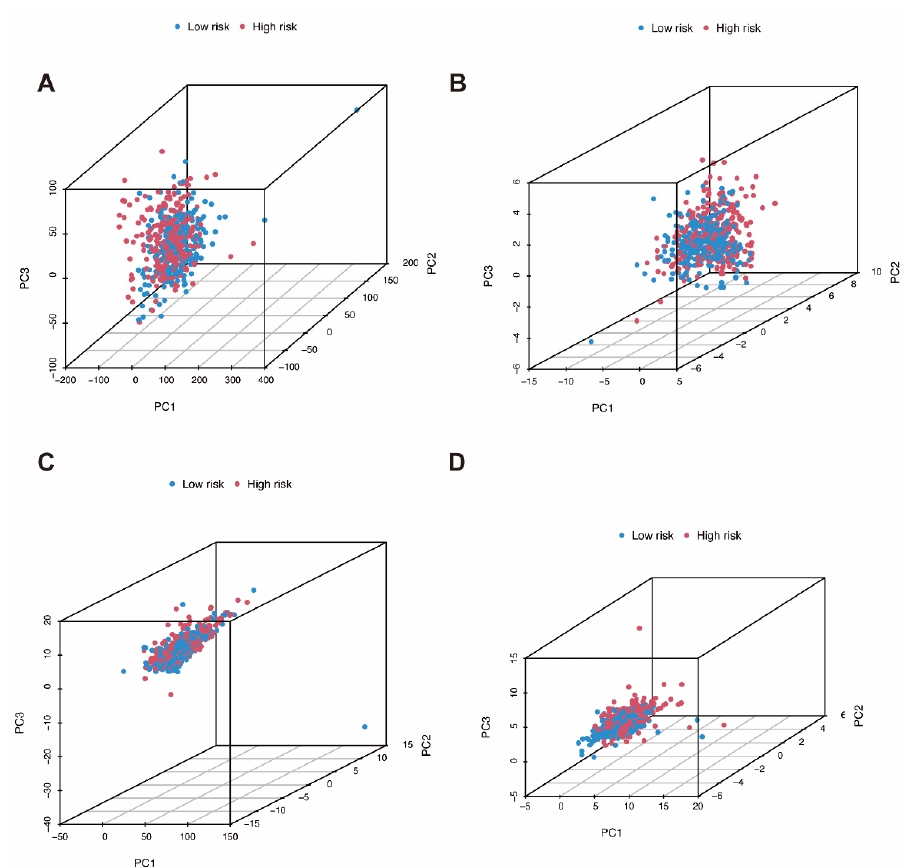
Figure 5. Principal component analysis. ( A ) The distribution of all genes. ( B ) The distribution of m7G-related genes. ( C ) The distribution of m7G-related lncRNAs. ( D ) The distribution of the m7G-related lncRNAs prognostic signature.